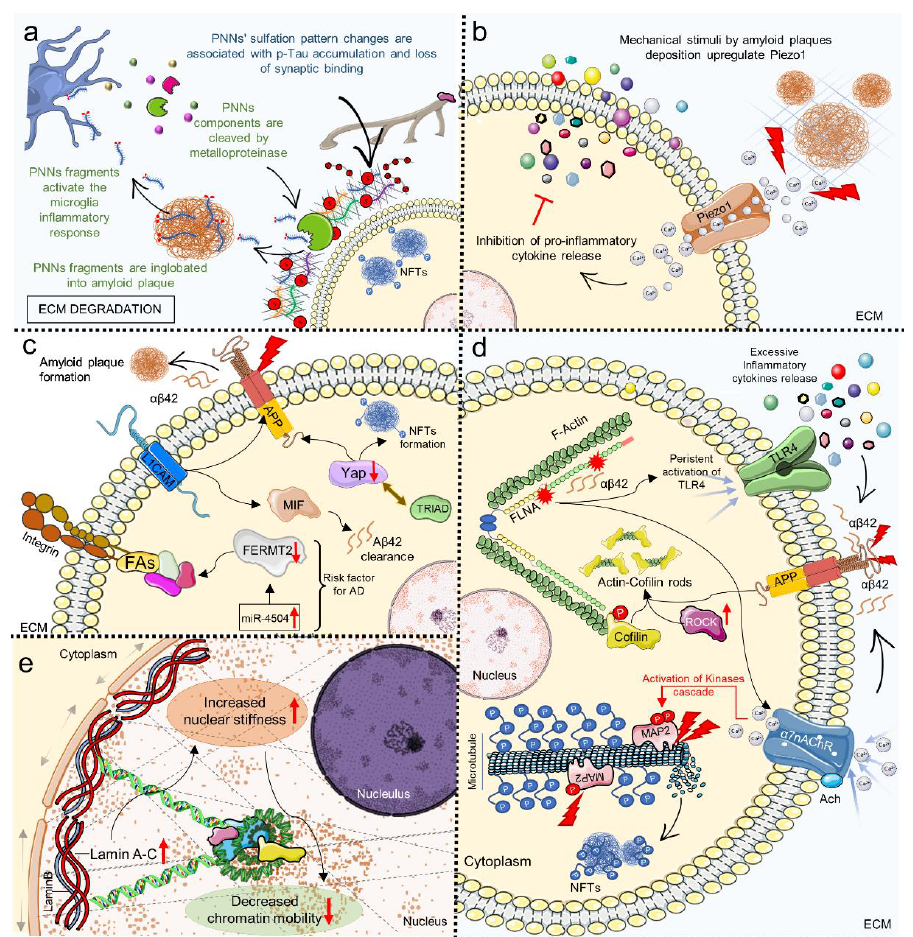
Figure 3. Biochemical pathways of cellular mechanosensing and mechanotransduction involved in Alzheimer’s Disease pathological mechanisms related to ( a ) The extracellular matrix (ECM); ( b ) Mechanosensitive Piezo channels; ( c ) Cellular adhesion and YAP signaling; ( d ) Cytoskeletal archi- tecture; and ( e ) Nucleoskeletal organization (see main text for details). Red arrows up ↑ or down ↓ indicate up or downregulation. ACh, Acetylcholine; AD, Alzheimer’s Disease; APP, Amyloid Pre- cursor Protein; A β 42, Amyloid Beta; Ca 2+ , Calcium ion; ECM, extracellular matrix; FAs, focal adhe- sions; FERMT2, Fermitin family homolog 2; FLNA, Filamin A; MAP2, Microtubule-associated pro- tein 2; MIF, macrophage migration inhibitory factor; NFTs, neurofibrillary tangles; PNNs, perineu- ronal nets; ROCK, Rho-associated protein kinase; TLR4, Toll-like receptor 4; YAP, Yes-associated protein 1; α7nAChR, α7 nicotinic acetylcholine receptor.